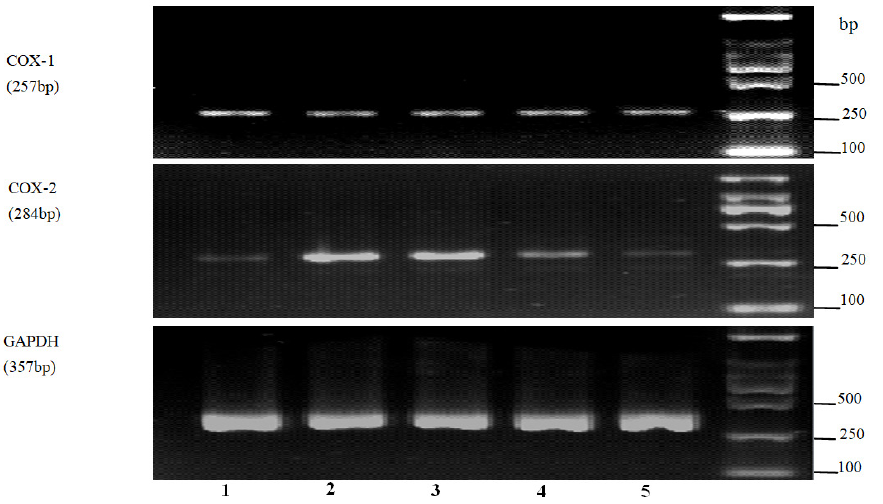
Figure 4: Effects of PTTTF on the expression of COX-1 and COX-2 in LPS-induced RAW264.7 cells by RT-PCR. 1: normal cells; 2: LPS; 3: 0.4μg/ml PTTTF; 4: 4μg/ml PTTTF; 5: 40μg/ml